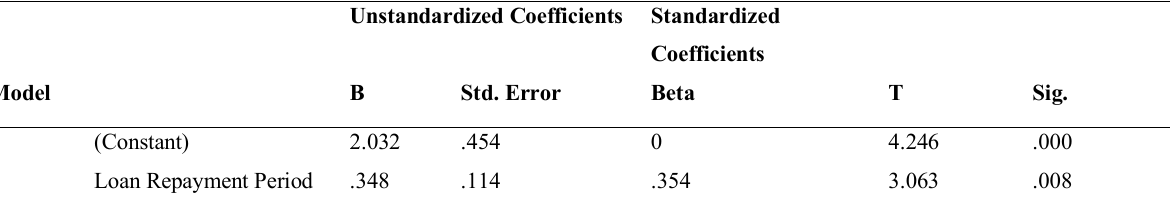
Table 9: Coefficients for Loan Repayment Period